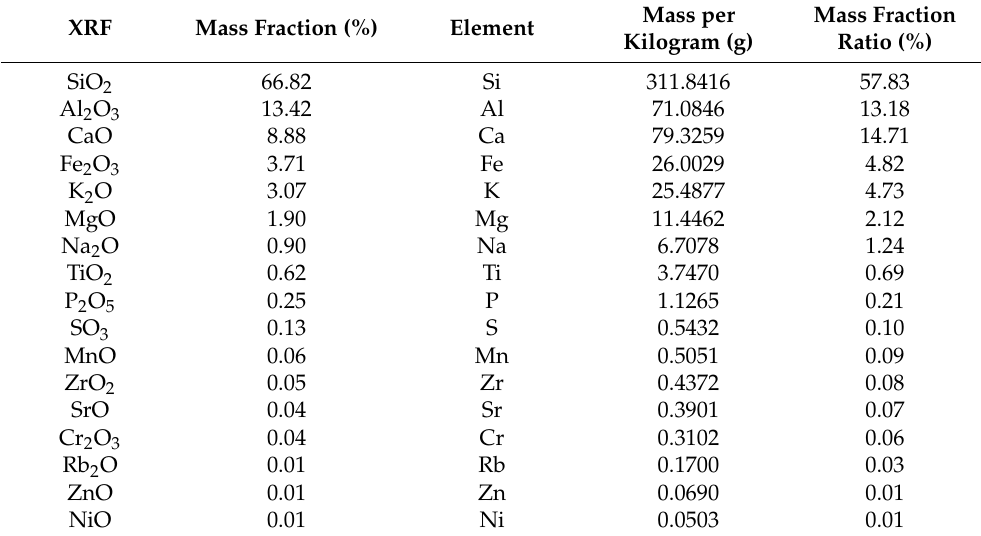
Table 1. Chemical properties of mine tailing